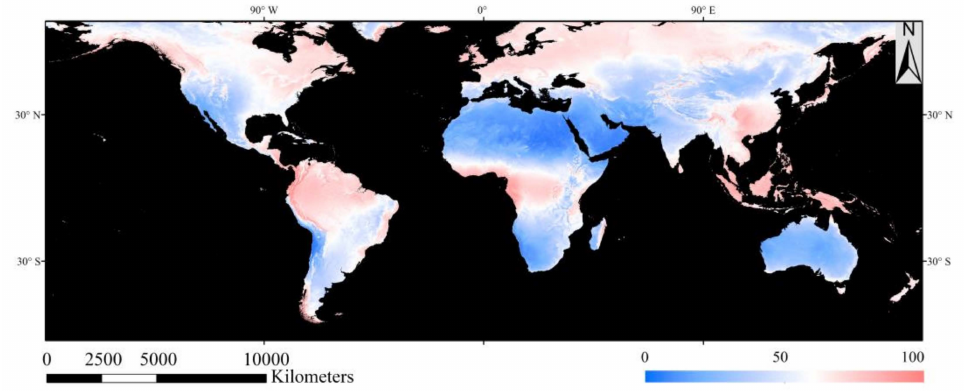
Figure 5. Mean annual cloud frequency (%) of the